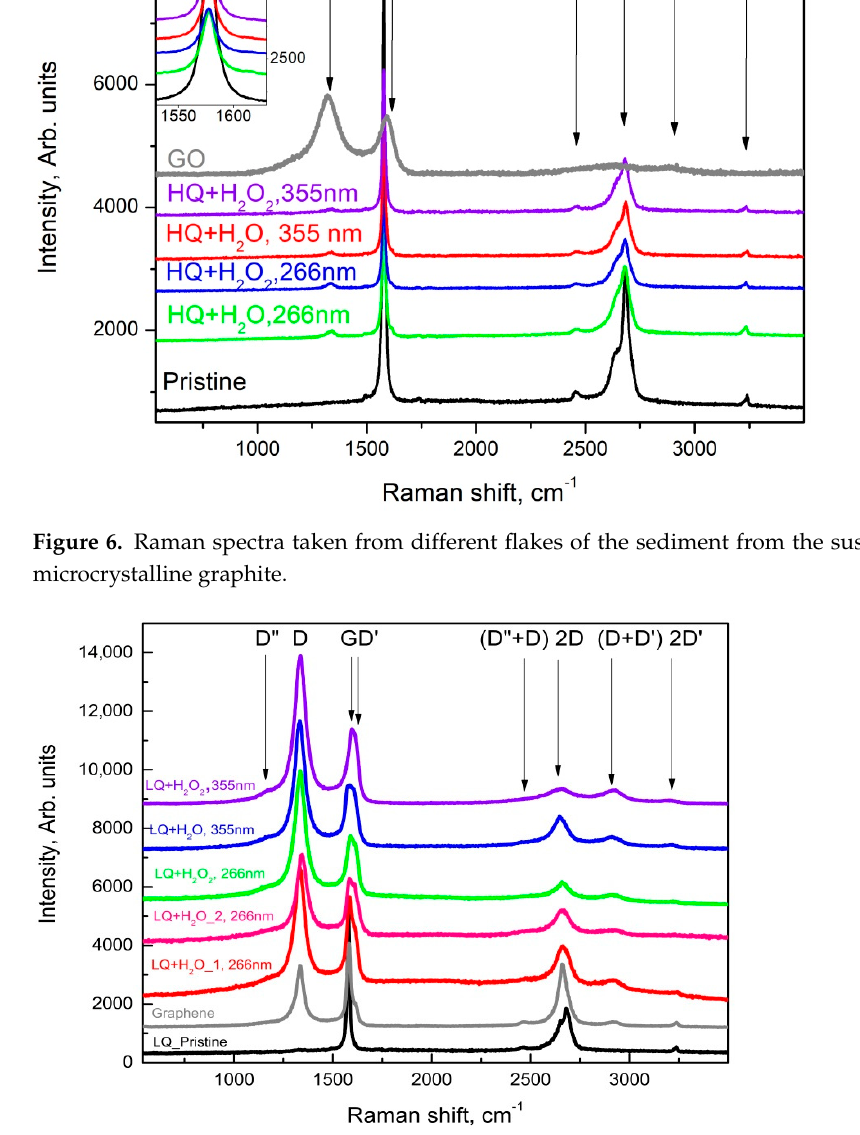
Figure 7. Raman spectra taken from different flakes of the sediment from the suspension LQ of microcrystalline graphite.